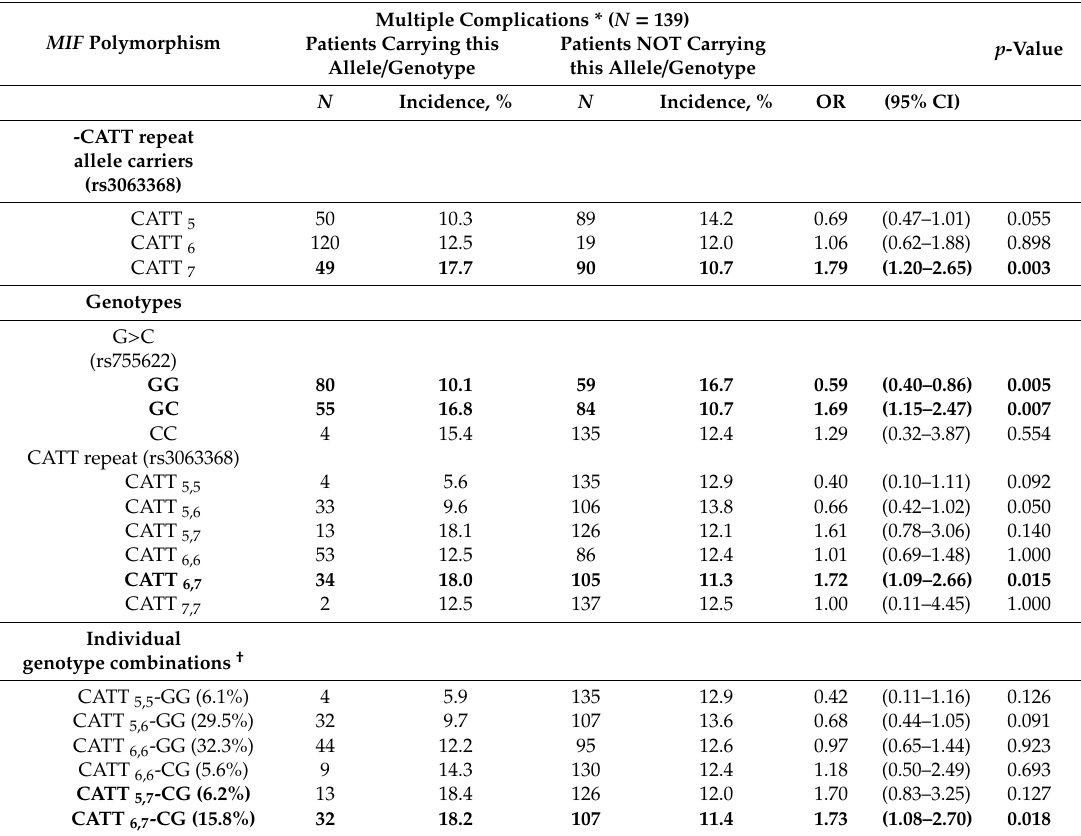
Table 5. Association of the MIF promoter polymorphisms with multiple complications *. MIF